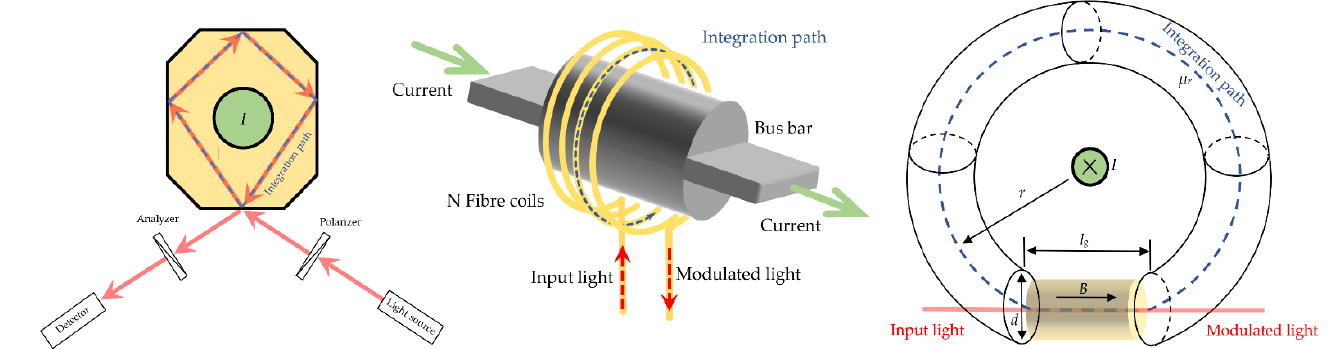
Figure 2. Methods for sensing electrical currents from left to right: a closed optical path through a Faraday material, a closed optical path through OF possessing FR and a magnetic concentrator encircling conductor with FC inside the gap. For homogeneous crystals the FA is (a) 𝜃 = ∮ 𝑉𝐵(cid:4652)⃗𝑑𝑙(cid:4652)(cid:4652)(cid:4652)⃗ = 𝜇 (cid:2868) 𝑉 ∮ 𝐻(cid:4652)(cid:4652)⃗𝑑𝑙(cid:4652)(cid:4652)(cid:4652)⃗ = 𝑉 (cid:3009) 𝐼 , and for N curls around the conductor the FA is (b) 𝜃 = ∮ 𝑉𝐵(cid:4652)⃗𝑑𝑙(cid:4652)(cid:4652)(cid:4652)⃗ = 𝜇 (cid:2868) 𝑉 ∮ 𝐻(cid:4652)(cid:4652)⃗𝑑𝑙(cid:4652)(cid:4652)(cid:4652)⃗ = 𝑁𝑉 (cid:3009) 𝐼 . For the concen-